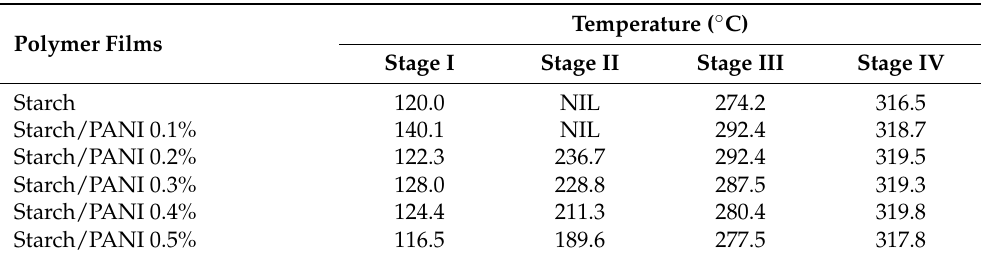
Table 1. Degradation temperatures of starch and starch/PANI (0.1%, 0.2%, 0.3%, 0.4%, 0.5%)- polymer films.